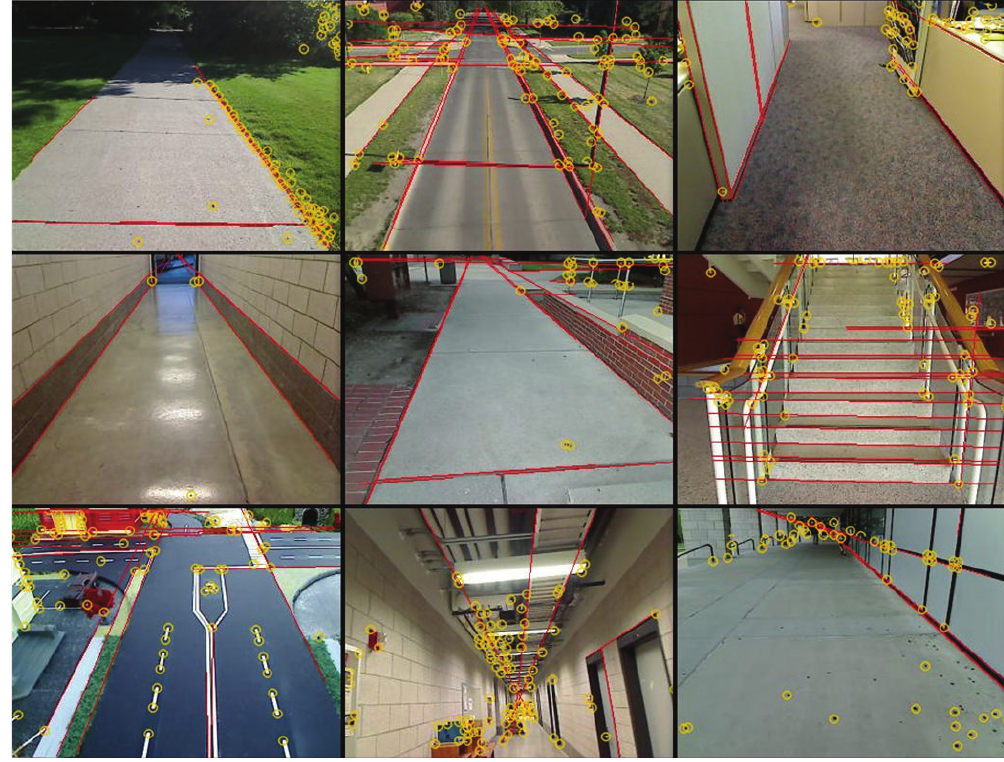
Figure 7: While we emphasize hallway like indoor environments, our range measurement strategy is compatible with a variety of other environments, including outdoors, office environments, ceilings, sidewalks, and building sides, where orthogonality in architecture is present. A minimum of one perspective line and one feature intersection is sufficient.